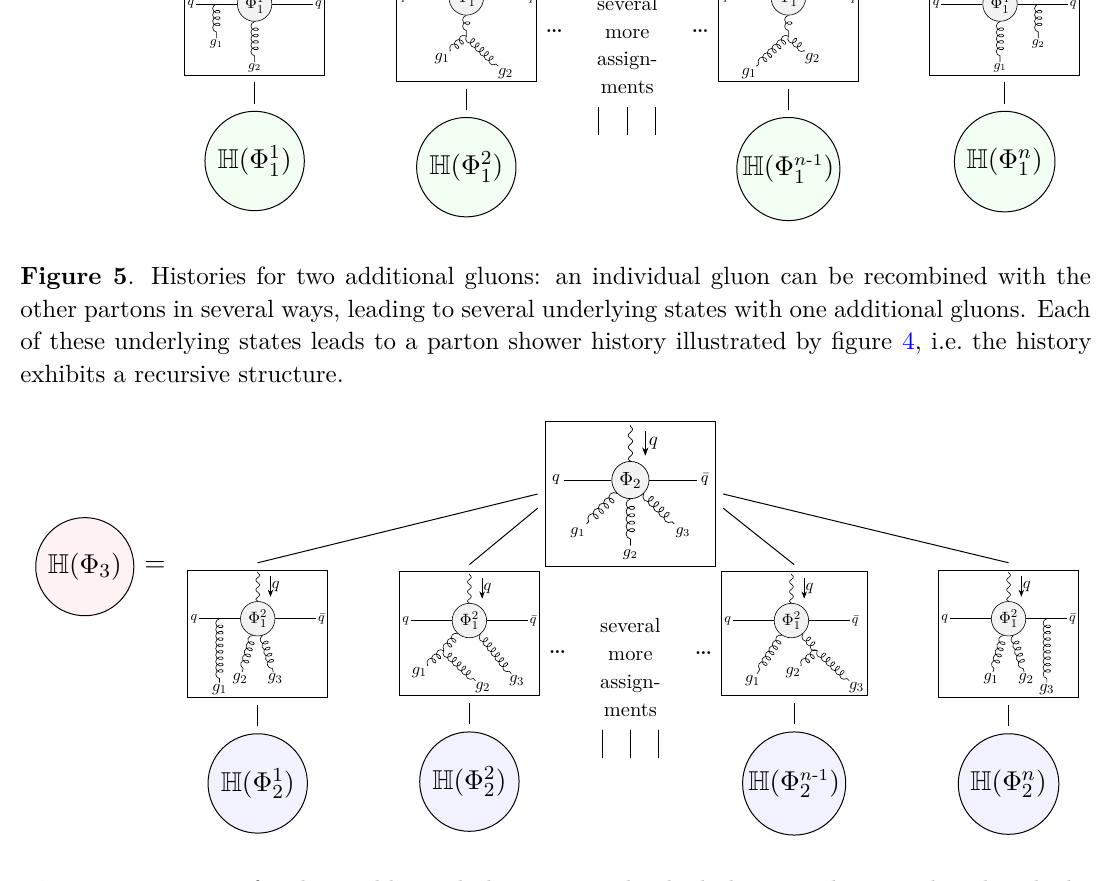
Figure 6 . Histories for three additional gluons: an individual gluon can be recombined with the other partons in several ways, leading to several underlying states with two additional gluons. Each of these underlying states leads to a parton shower history illustrated by figure